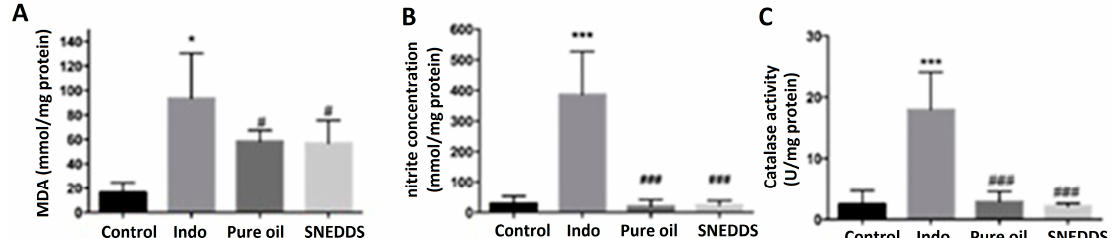
Figure 3. Bar graphs showing the effect of indomethacin, pure omega-3 oil, and SNEDDS formula on mucosal MDA ( A ), mucosal catalase ( B ), and mucosal nitrites ( C ). Data are presented as mean ± S.E.M. * Significantly different from control at p < 0.05. *** Significantly different from control at p < 0.001. # Significantly different from indomethacin at p < 0.05. ### Significantly different from indomethacin at p < 0.001. Indo: Indomethacin, Pure oil: omega-3 oil, SNEDDS: omega-3 formula.